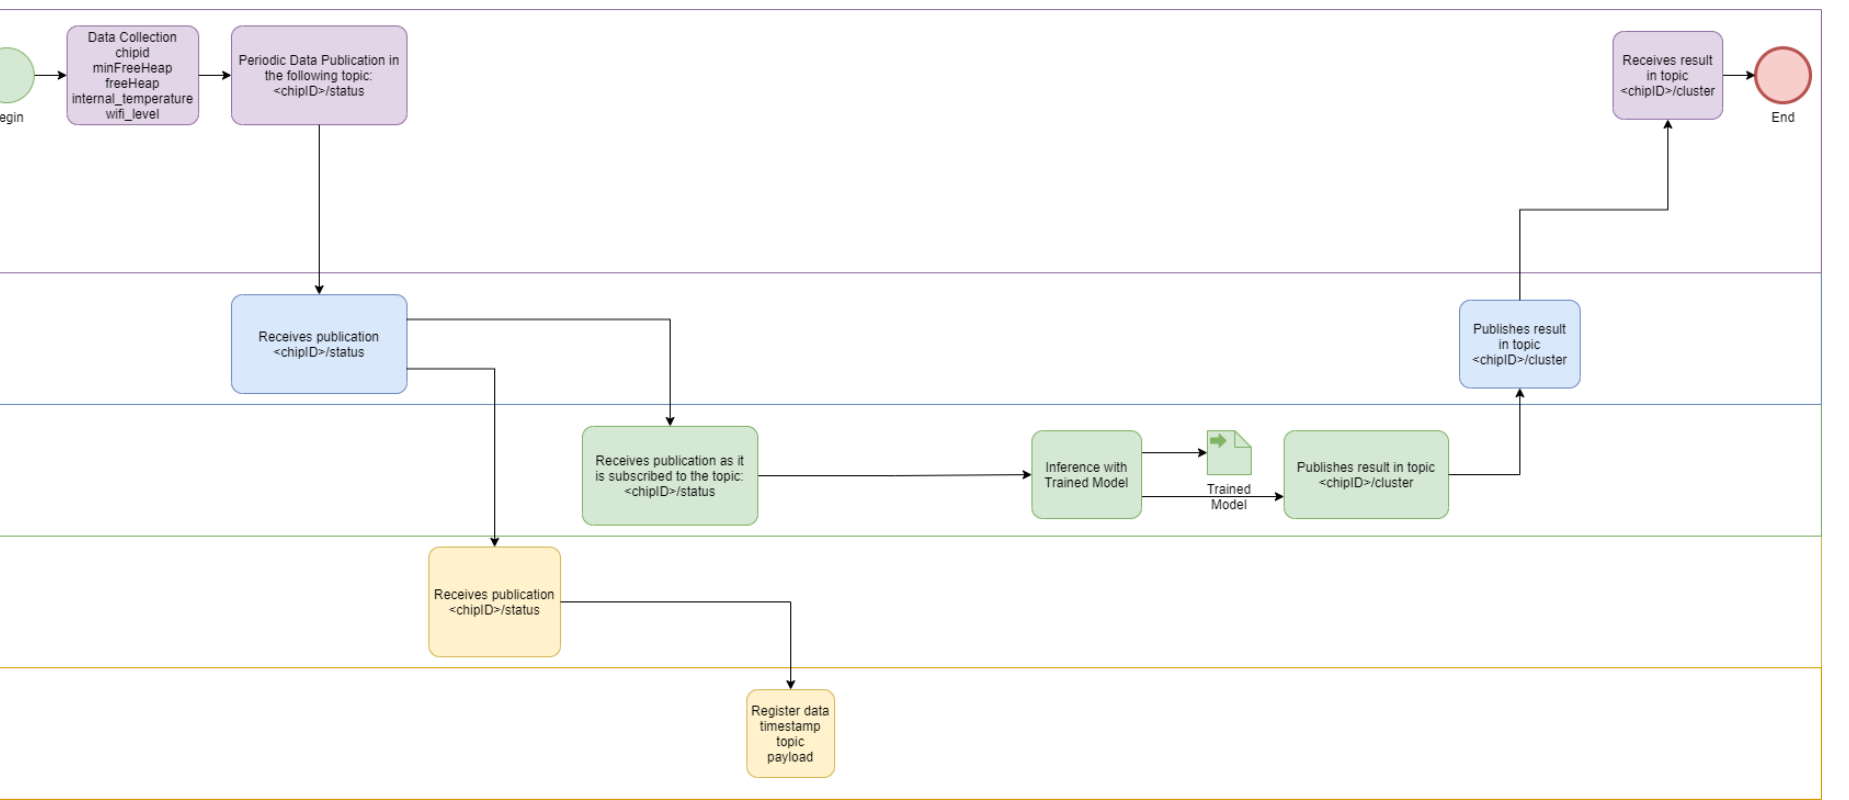
Figure 4. BPMN diagram of the inference phase of the automated